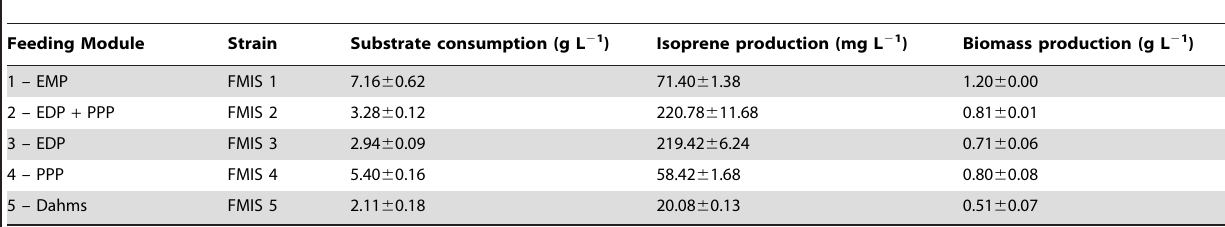
Table 1. Substrate consumption, isoprene and biomass productions from different feeding modules a .